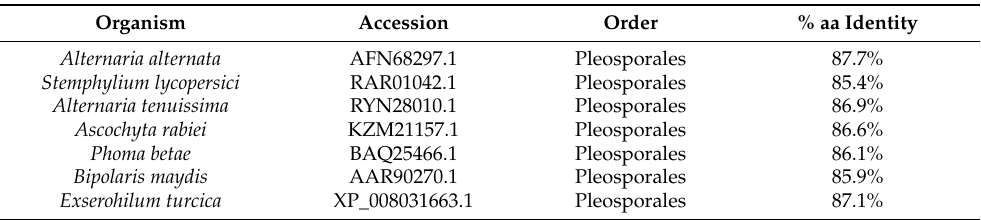
amino acid identity of 85–88% with the top seven matches, which were all Alternaria spp. or other Pleoporales (Table 5, Figure 4).